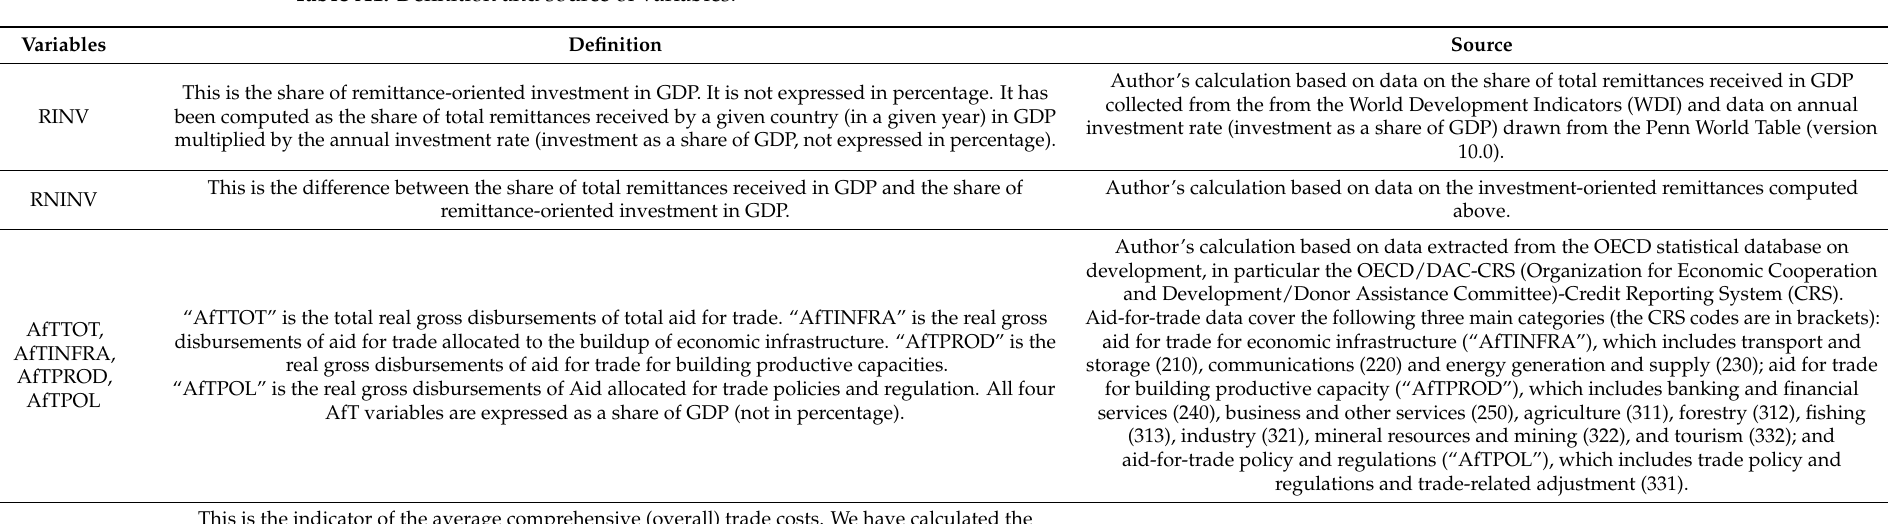
Table A1. Definition and source of